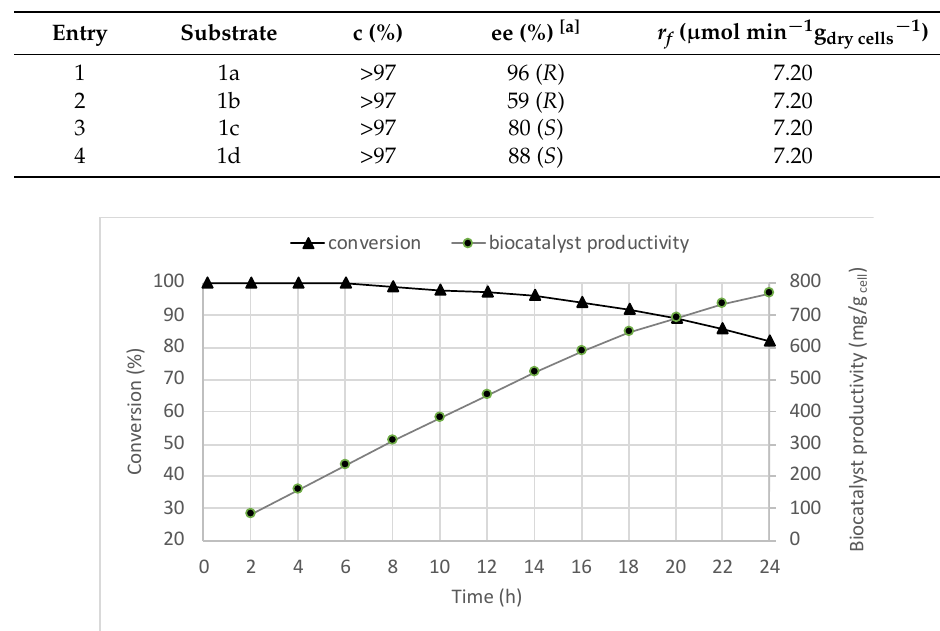
Figure 4. Continuous enantioselective oxidation of 1a with immobilized Acetobacter aceti MIM 2000/28 in flow under the conditions reported in Table 2, entry 5. Biocatalyst productivity is defined as the overall amount of product (mg) formed per dry weight of biocatalyst.